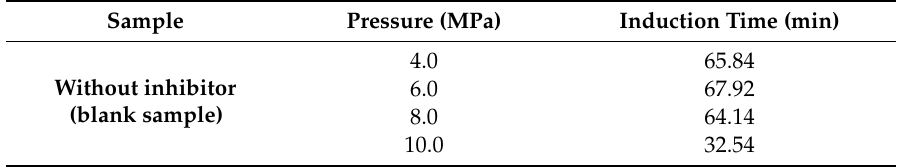
Table 3. Methane hydrate induction without inhibitor (blank sample).